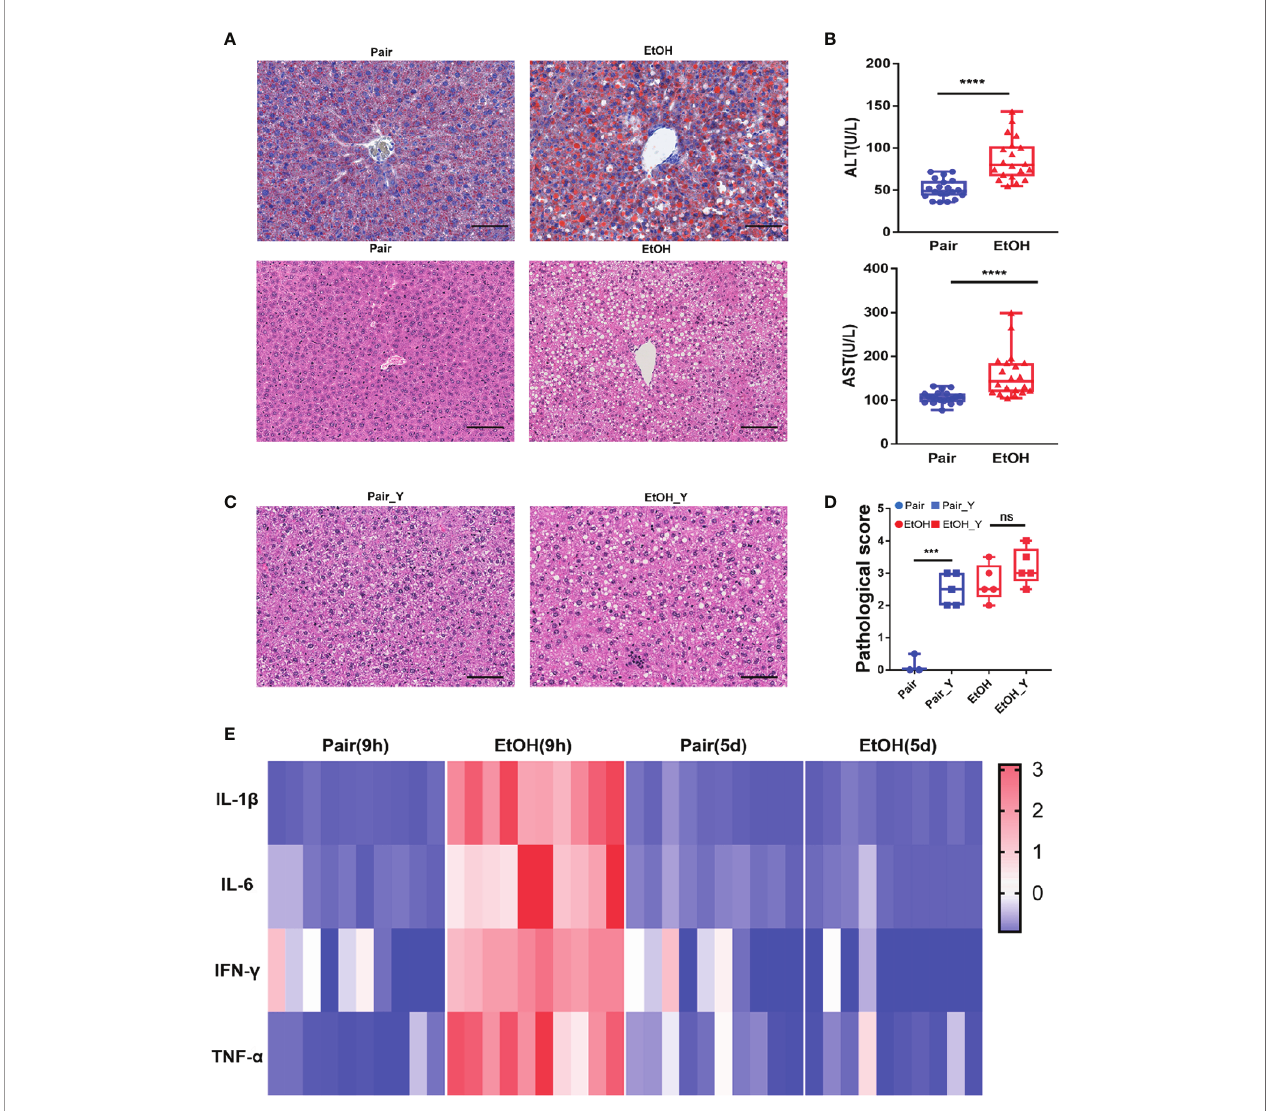
FIGURE 1 | Evaluating the mouse model of ALD. (A) Representative oil red O and H&E staining in the liver tissues from the Pair and EtOH groups. Scale bars, 100 m m. There are round vacuoles of varying sizes, which are lipid droplets formed by fat accumulation in the liver cells of the EtOH group. (B) Serum ALT and AST levels (U/L) in mice from the EtOH group or the Pair group 9 hours post alcohol or maltodextrin gavage, respectively. (n = 20, *** P < 0.001, **** P < 0.0001). (C) Representative H&E in the liver tissues from mice in the Pair_Y and EtOH_Y groups. (D) Pathological scores of liver tissues in the Pair, EtOH, Pair_Y, and EtOH_Y groups. (E) Cytokine concentrations in plasma 9 hours and 5 days post gavage (n = 10). The concentrations of cytokines were standardized by z-score, with red indicating a higher concentration and blue indicating a lower concentration. ns, no signi fi